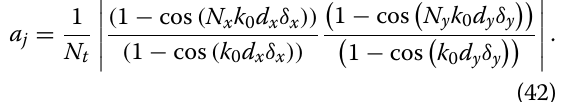
k -th user is fixed to be θ k = π/ 6, the inter-antenna spac- ing in horizontal direction is set to d x = d y = λ/ 2, and the number of BS antennas is 36, 64, 100, 400, and 1000, respectively. The fluctuations of the curves are due to cos function in (42). The crosstalk coefficient decreases when the number of BS antennas increase or when angle difference between two steering vectors increases. In par- ticular, for the case with very large antenna arrays, a j decreases rapidly. In this case, nearby users can be easily distinguished by the azimuth angle. Figure 3 shows the normalized crosstalk versus inter- antenna spacing d y in the vertical direction. In the sim- ulations, we choose fixed angles corresponding to user positions θ k = θ j = π/ 4, φ k = φ j = π/ 4, and the inter- antenna spacing in horizontal direction is set to d x = λ/ 2. The number of antennas in both horizontal and the verti- cal directions is eight; thus, the total number of antennas